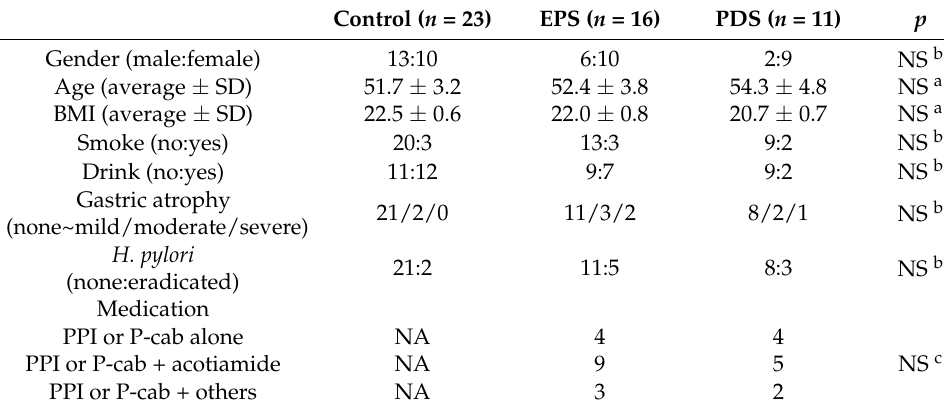
Table 1. Clinical background of the enrolled